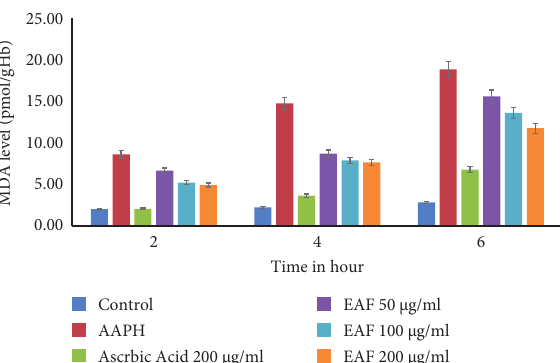
Figure 3: Level of MDA after treating with EAF and standard ascorbic acid. Values are expressed as mean ± SD of three experiments. Table 1: Effects of EAF on viable Ehrlich’s ascites carcinoma (EAC) cell growth. Treatment group